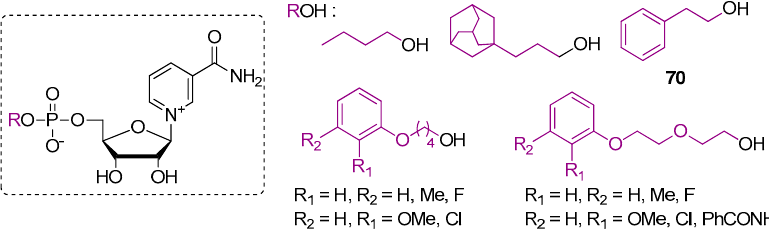
Figure 16. Phosphodiester analogs tested as bacterial and yeast growth enhancers, including the most potent compound 70 [81].